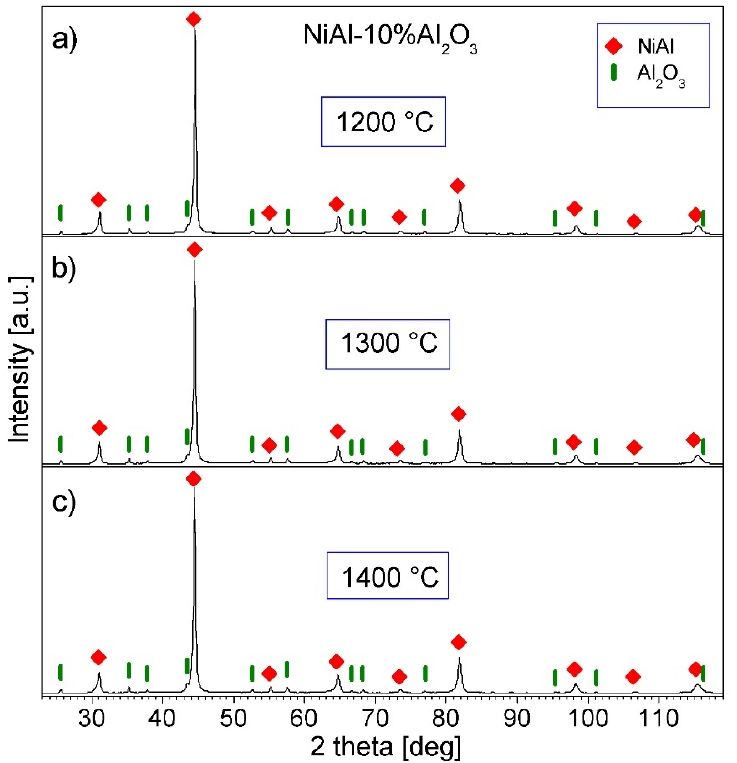
Figure 9. XRD patterns of the NiAl-10%Al 2 O 3 samples consolidated by PPS: ( a ) at 1200 °C; ( b ) at 1300 °C; ( c ) at 1400 °C. The SEM images obtained in the BSE (backscattered electron) mode presented in